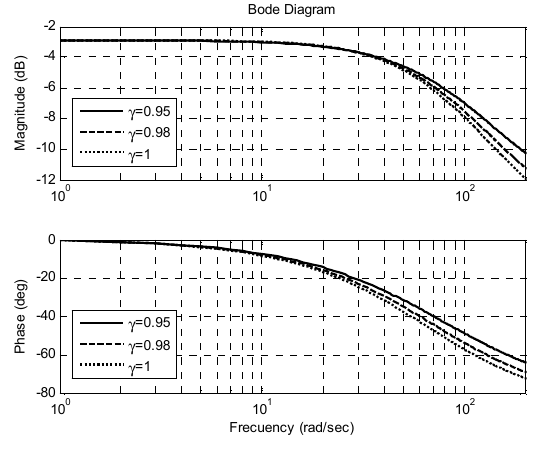
Fig. 7: Equivalent electrical circuit for data of blood tissue, erythrocytes, leukocytes and plasma. Table 1: Values for the erythrocytes, leukocytes and